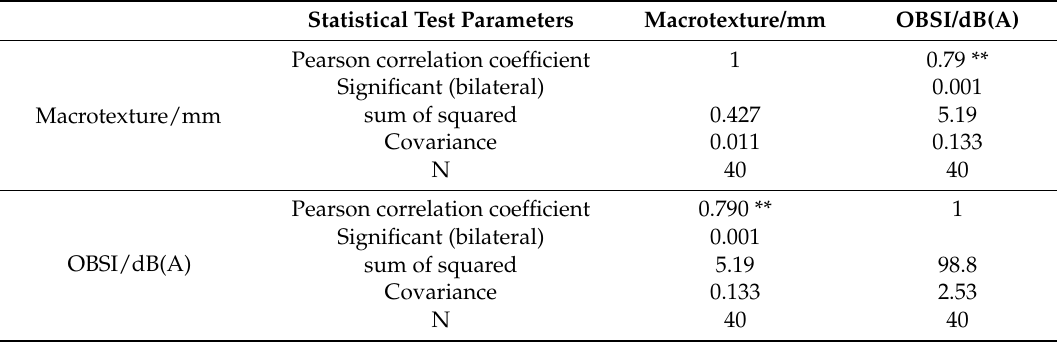
** means the correlation was significant at the level of 0.01 (both sides).